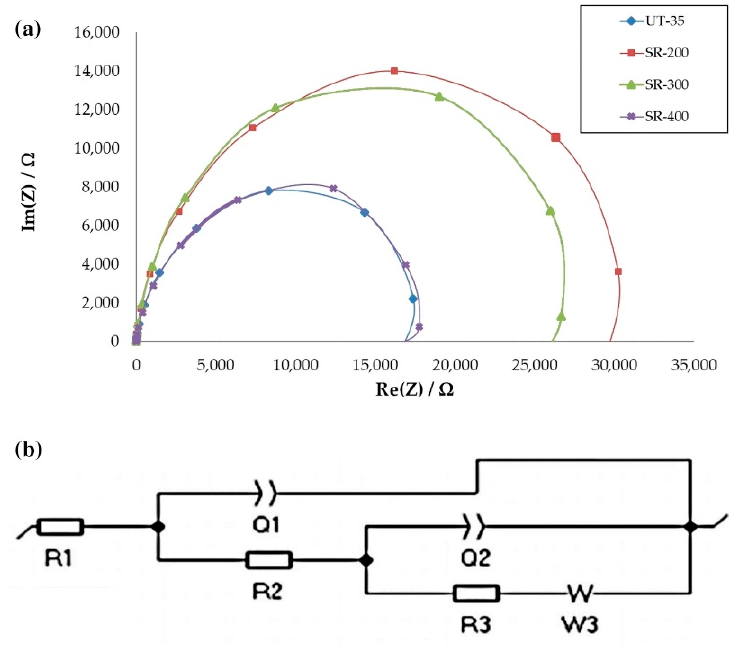
Figure 12. EIS spectra of the samples tested in Harrison solution: ( a ) Nyquist plot; ( b ) the fitting equivalent circuit [83].